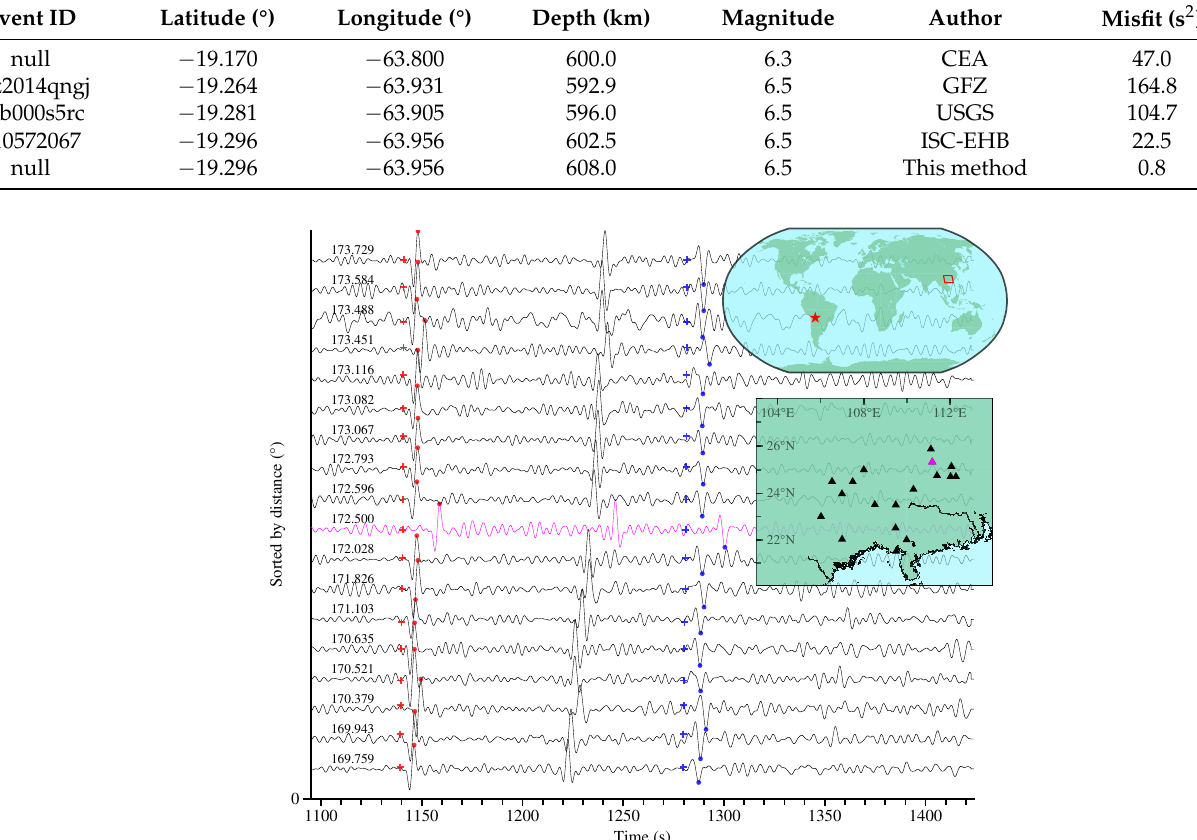
Figure 3. The seismic stations are shown by black triangle in the subfigure. Observed seismograms, picks and theoretic traveltime of PKIKP and pPKIKP phases in portable network for the event occurred on 21 February 2017, Mw 6.5, Bolivia. The magenta-colored waveform may have the time synchronization problem. See Figure 2 for key to